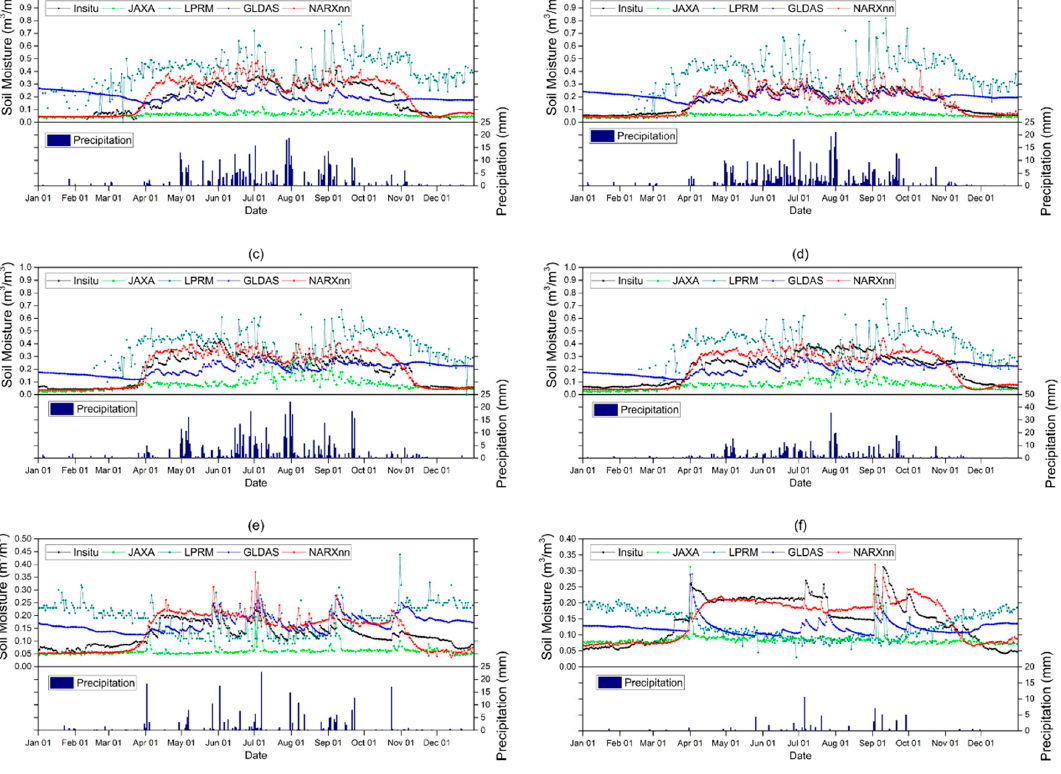
Figure 6. Temporal plots of in situ SM and the JAXA, LPRM, GLDAS and NARXnn SM products during the validation period (2015): ( a ) WATER-NET 1, ( b ) WATER-NET 2, ( c ) WATER-NET 3, ( d ) WATER-NET 4, ( e ) HM-NET 1; and ( f ) HM-NET 2.